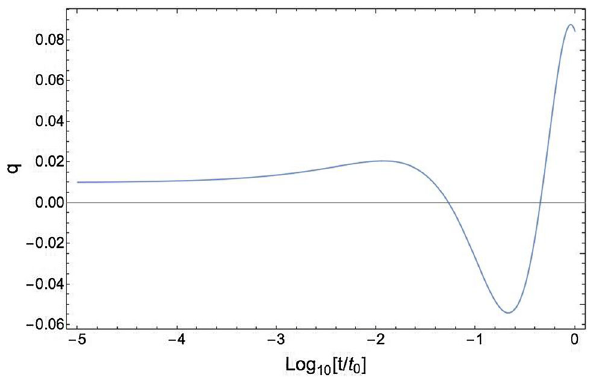
Fig. 1 Sample plot of the analytic formula of quintessence in the matter-dominated-era: α = 2 ,λ = 1 , Z χ = 1. t 0 = 1 is the present time